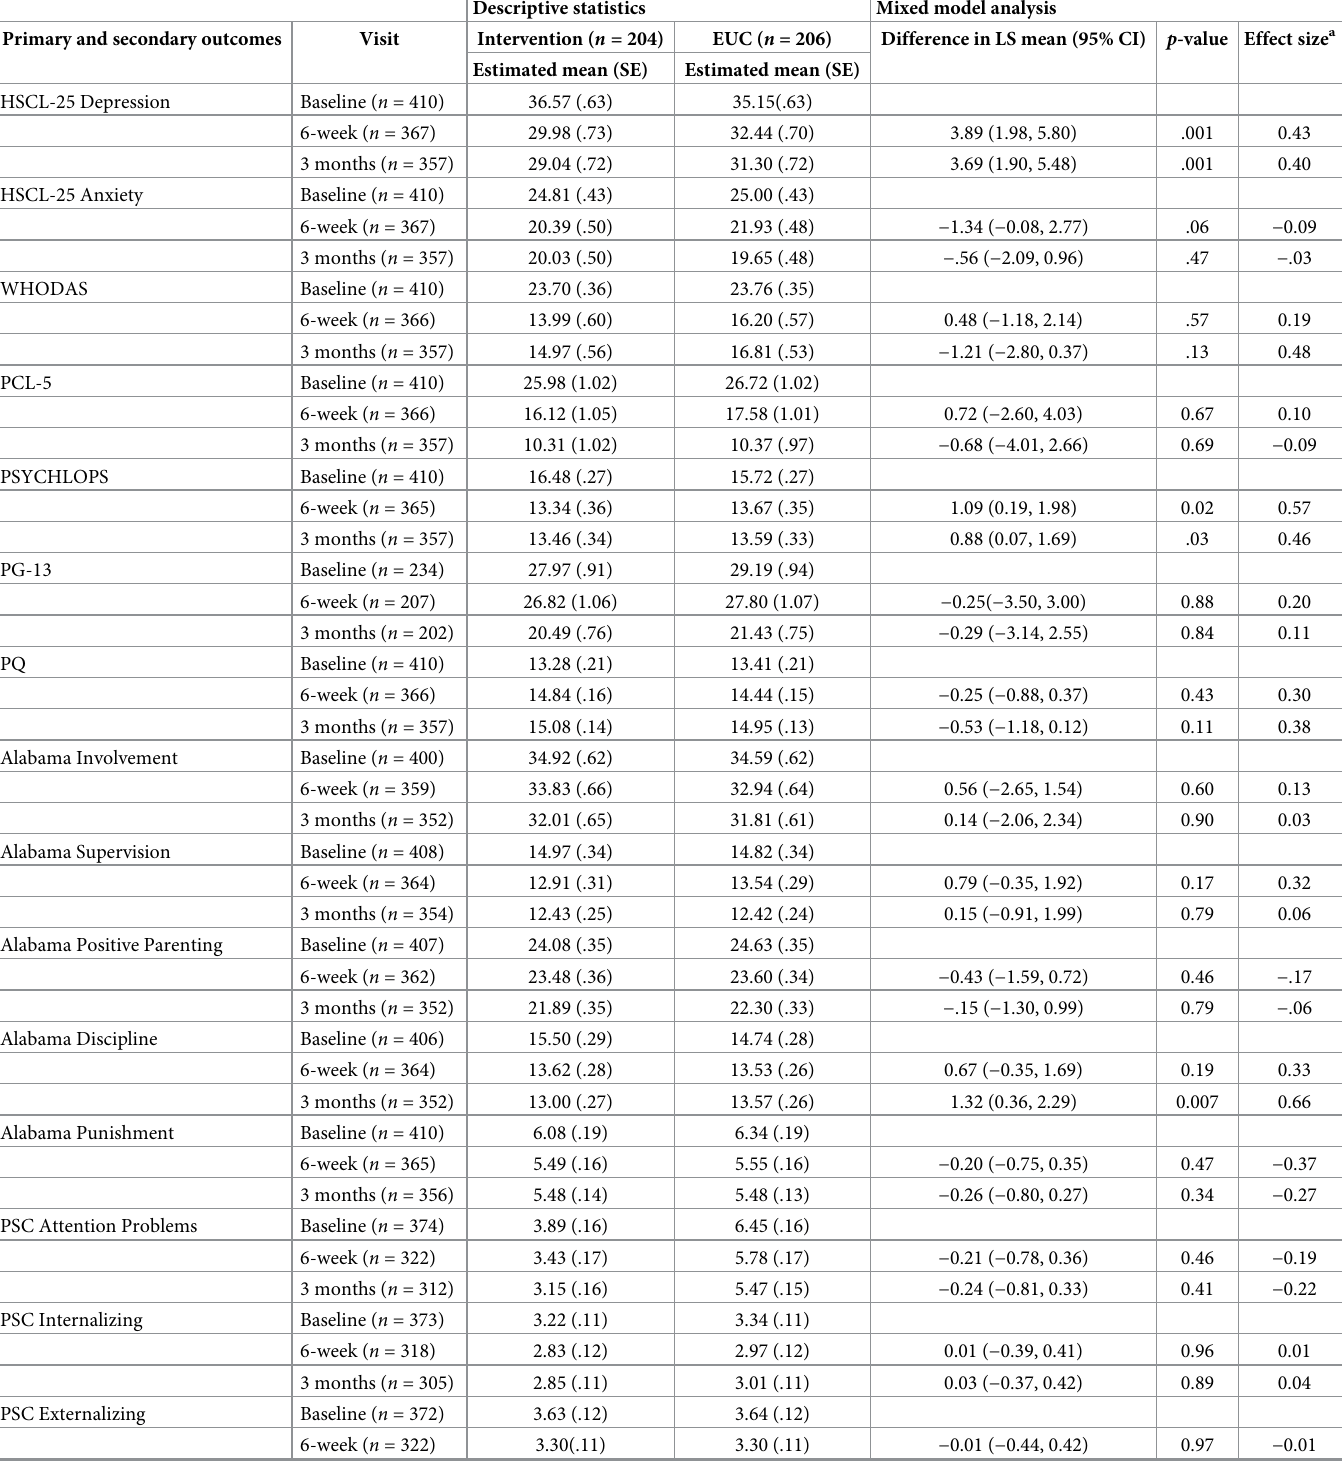
Table 3. Summary statistics and results from mixed model analysis of primary and secondary outcomes. Descriptive